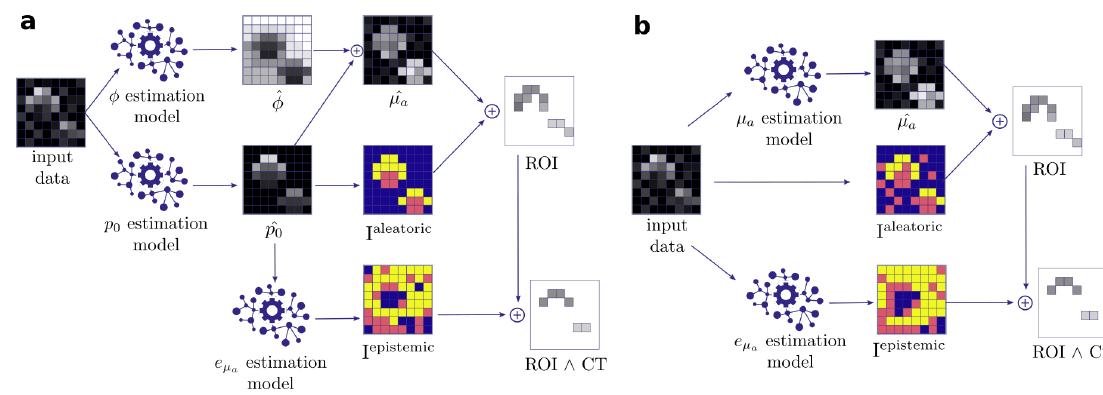
Figure 3. Visualization of the two methods for absorption quantification with subsequent confidence estimation. ( a ) A quantification approach based on fluence estimation. In our